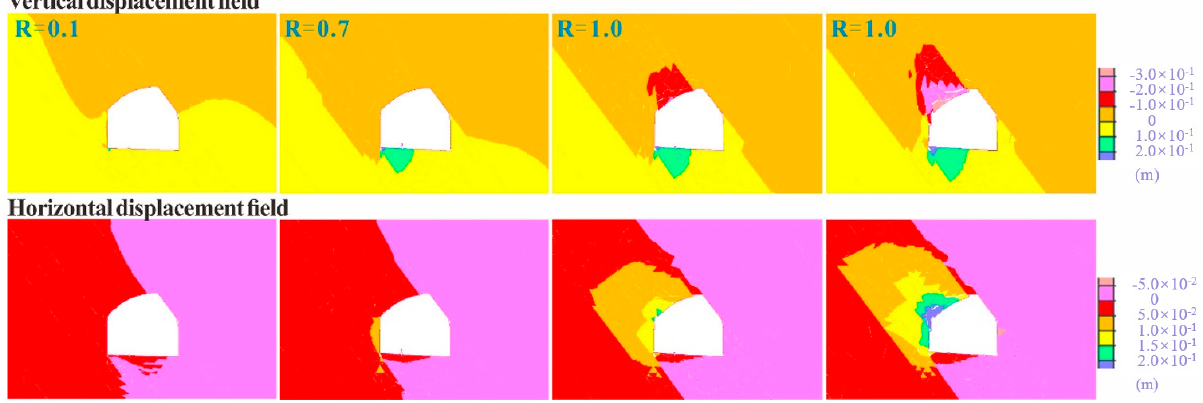
Figure 9. Nephogram of the displacement field of the surrounding rocks of the roadway.